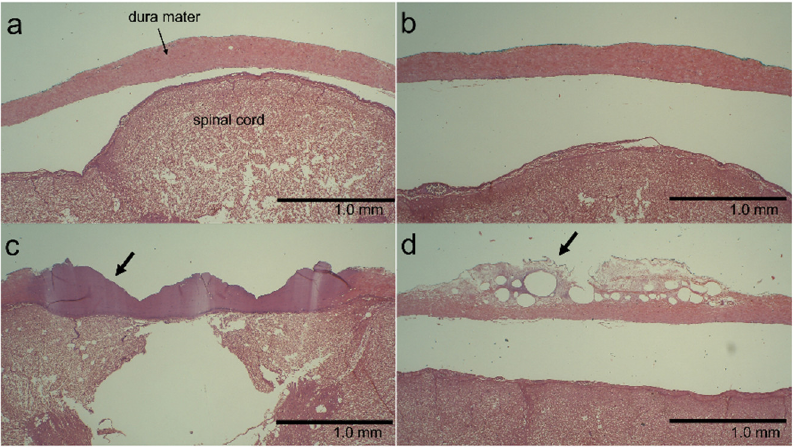
Figure 6. Examples of histological changes in the dura mater. ( a ) Control. ( b ) No noteworthy change is seen (10 g load, covered with a neurosurgical cotton pattie). ( c ) Coagulative necrosis-like change (arrow; 50 g load, uncovered). ( d ) Vesicle formation with edema (arrow; 2 g load, uncovered).